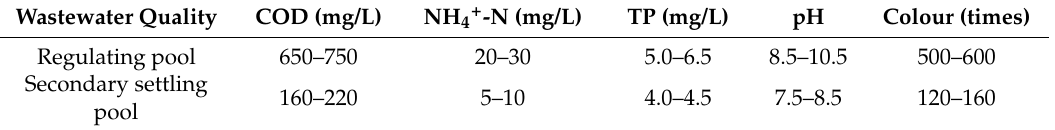
Figure 1. Treatment process in the printing and dyeing wastewater treatment plant. Table 2. Quality of influent and effluent wastewater from printing and dyeing.